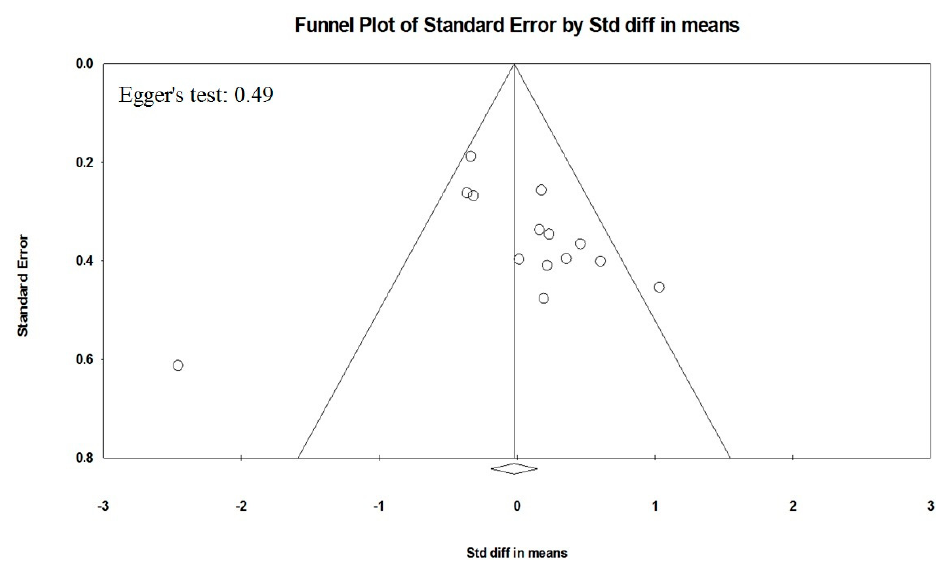
Figure 4. Publication bias. Funnel plots of effect size versus standard error for studies evaluating BDNF levels in obese patients and controls.